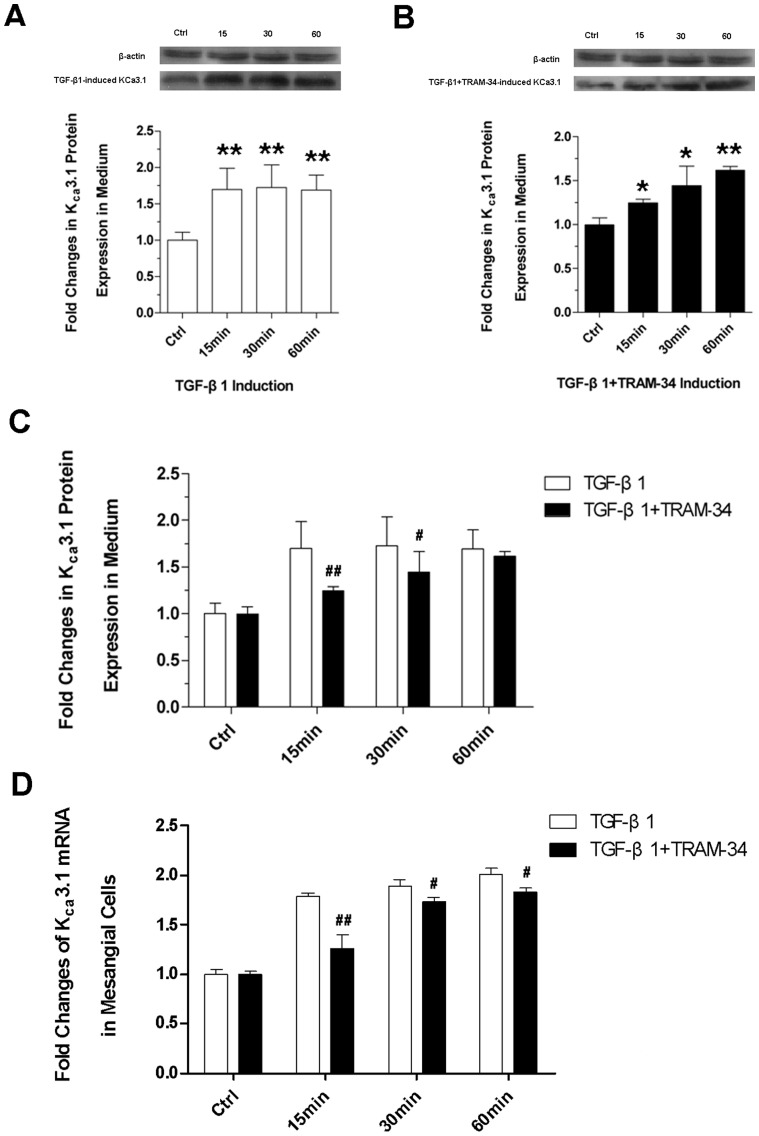
Expression of Kca3.1 channel.(A) Immunoblotting analysis of TGF-β1-induced Kca3.1 and (B) TGF-β1+TRAM-34-induced Kca3.1 protein expression with different induction time (15 min, 30 min, 60 min); (C) Differences between the TGF-β1- and the TGF-β1+TRAM-34-induced Kca3.1 protein expression at three time points; (D) RT-PCR assessments for Kca3.1 mRNA expression at three time points (* P<0.05 and ** P<0.01versus control; # P<0.05 and ## P<0.01 versus the TGF-β1-induced; n = 3).